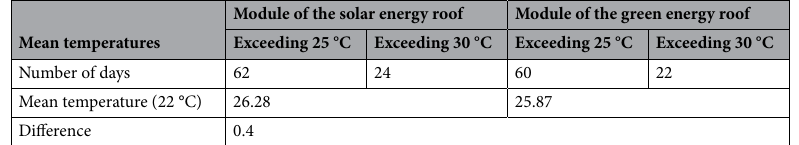
Table 12. Solar module temperatures.